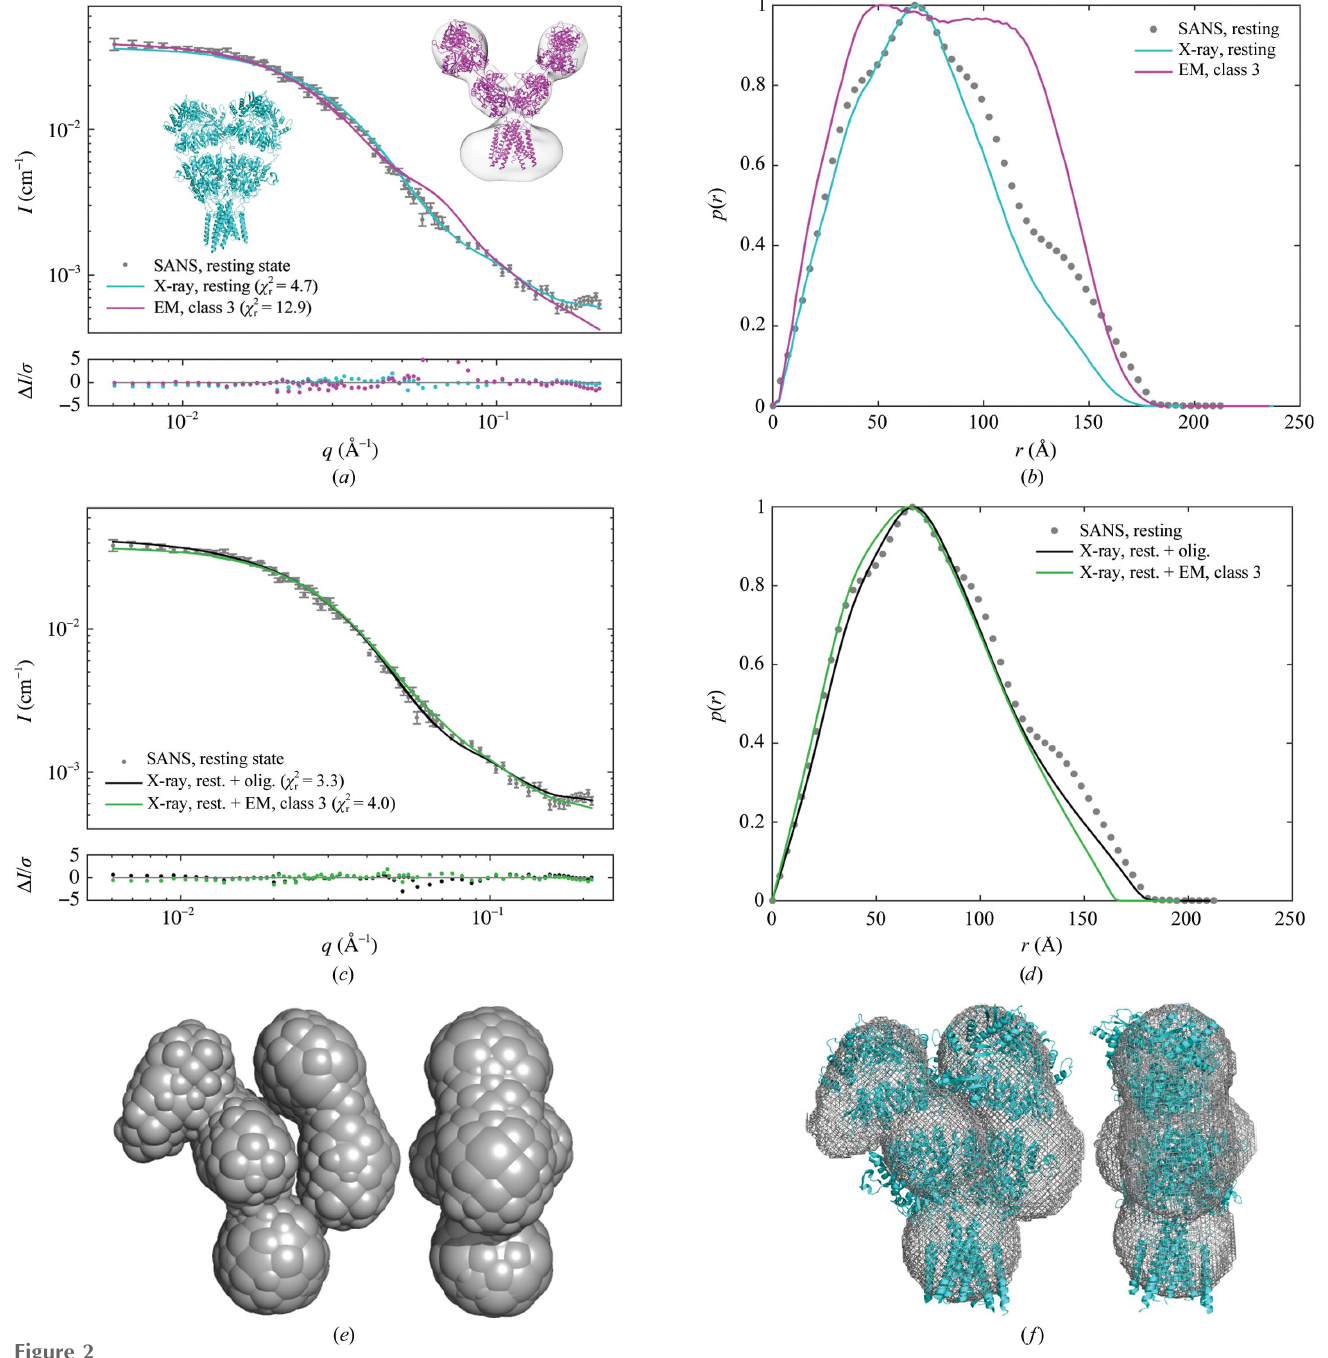
Figure 2 SANS data for GluA2 in the resting state (apo). ( a ) Experimental data (grey points), the resulting fits and residual plots, fitted with the X-ray crystal structure of GluA2 in the resting state (PDB entry 4u2p; cyan; Du¨rr et al. , 2014) and the EM structure of GluA2 with quisqualate (class 3; EMD-2688; magenta; Meyerson et al. , 2014). A cartoon representation of the crystal structure of GluA2 is shown in cyan and an atomic model fitted into the class 3 EM structure is shown in magenta. ( b ) Pair distance distribution function [ p ( r )] for the experimental GluA2 data in solution (grey points) and theoretical p ( r ) functions for the GluA2 crystal structure in the resting state (cyan) and for the GluA2 class 3 EM structure (magenta). ( c ) Experimental SANS data and the fit of a linear combination of the crystal structure of GluA2 in the resting state and fractal oligomers (black), and a linear combination of the crystal structure and the class 3 EM structure (green). ( d ) Pair distance distribution functions for the fits. ( e ) Ab initio model generated with DAMMIF . The size of the beads was weighted by occupancy. ( f ) The GluA2 crystal structure in the resting state (PDB entry 4u2p; cyan) was manually overlaid with the DAMMIF envelope